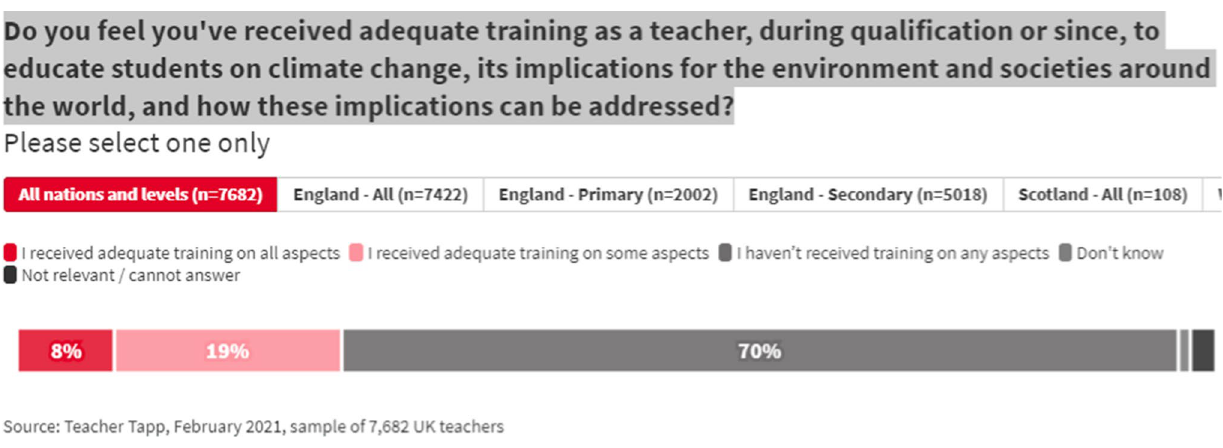
Fig. 1 Responses from teachers on climate change training